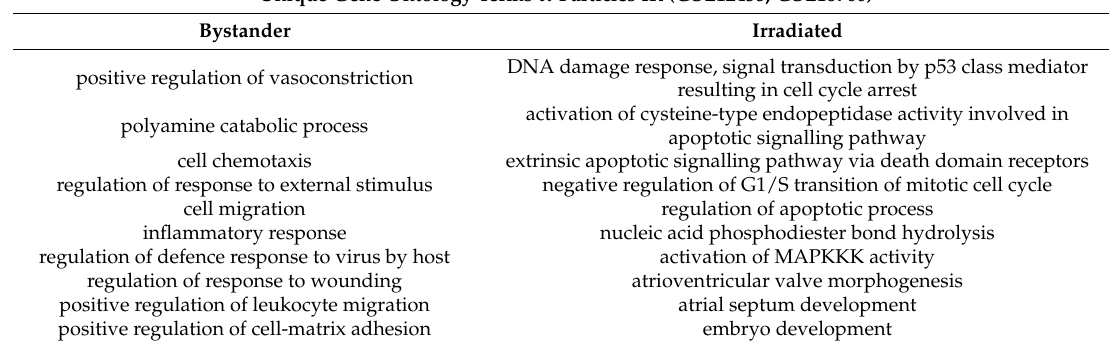
Table 5. Evaluation of differences in Gene Ontology terms resulting from functional enrichment analysis of datasets GSE12435 and GSE18760 from unique DE genes between comparisons of bystander vs. control and irradiated vs. control